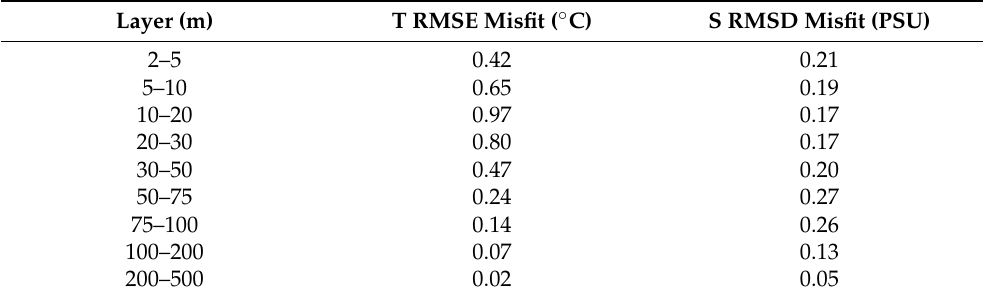
Table 2. Temperature and salinity RMSE misfits over the period 2018–2019. Layer (m) T RMSE Misfit ( ◦ C) S RMSD Misfit